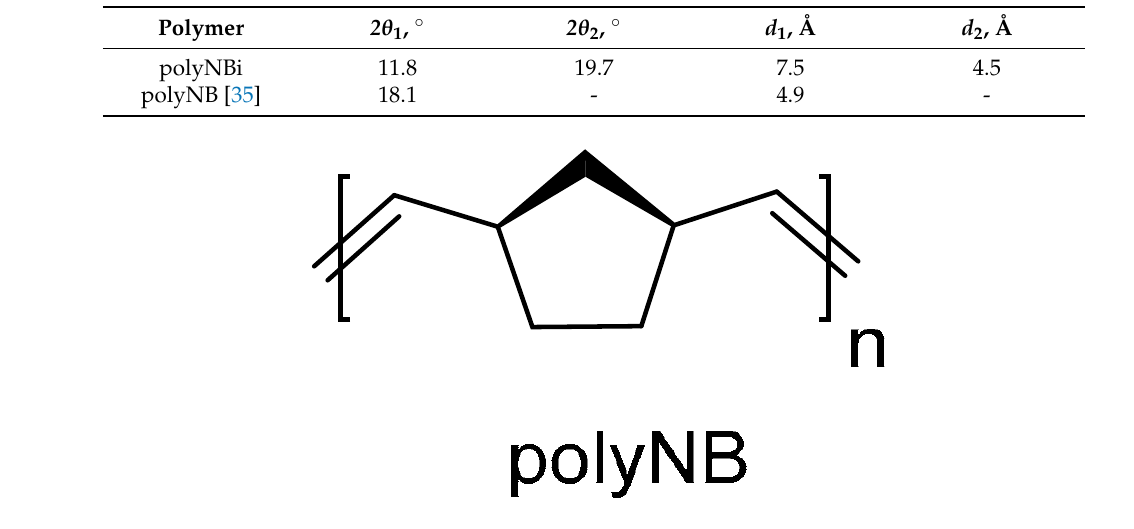
Table 2. WAXD data for polyNBi in comparison with unsubstituted metathesis polynorbornene (polyNB).